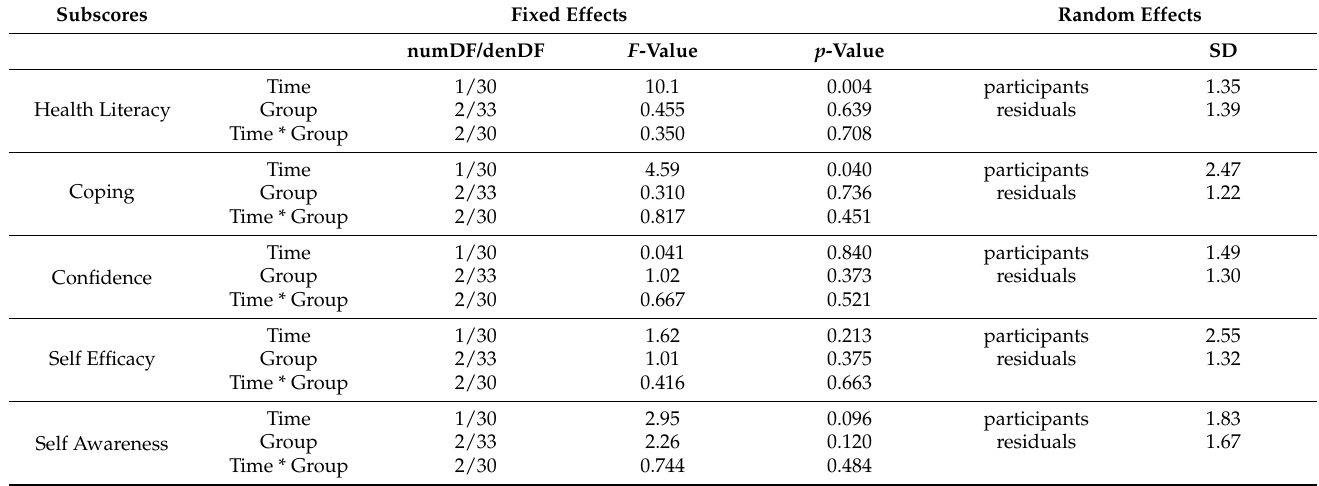
Table 4. Results of the mixed effects models for patient empowerment outcome